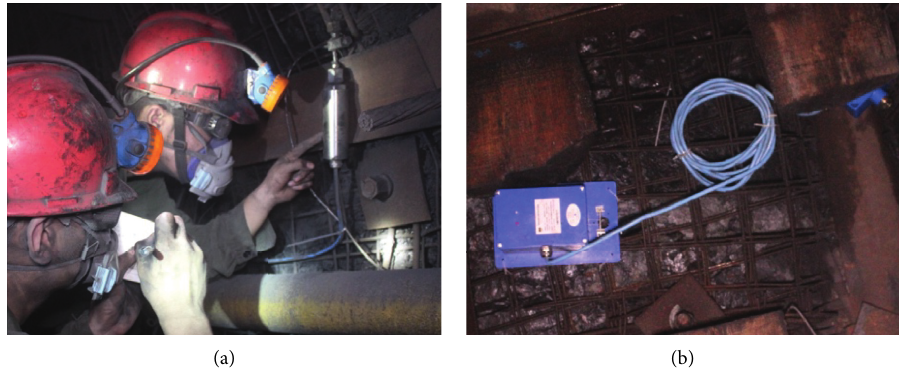
Figure 3: Installation of the monitoring apparatus. (a) Stress sensor. (b) Displacement